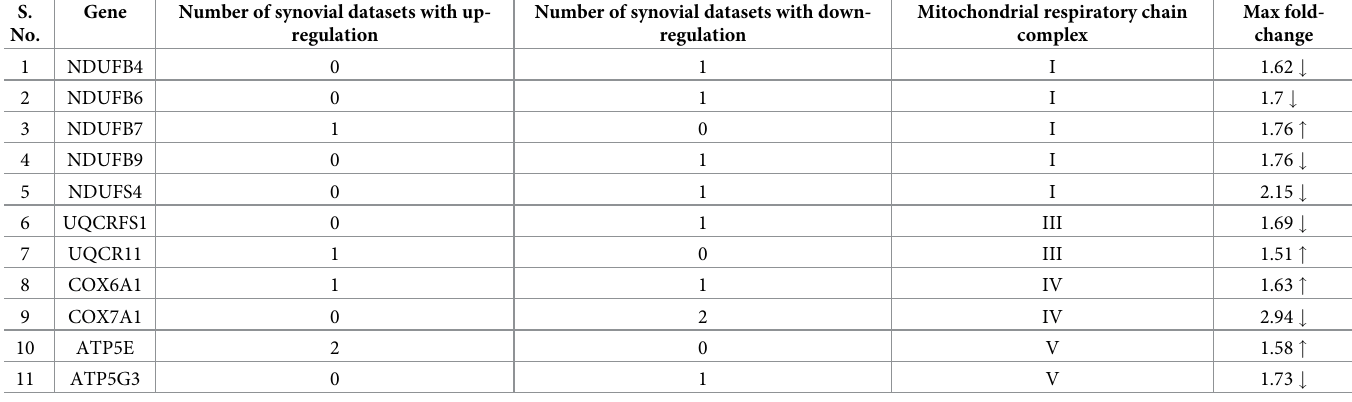
The up and down arrows indicate up and down-regulation,